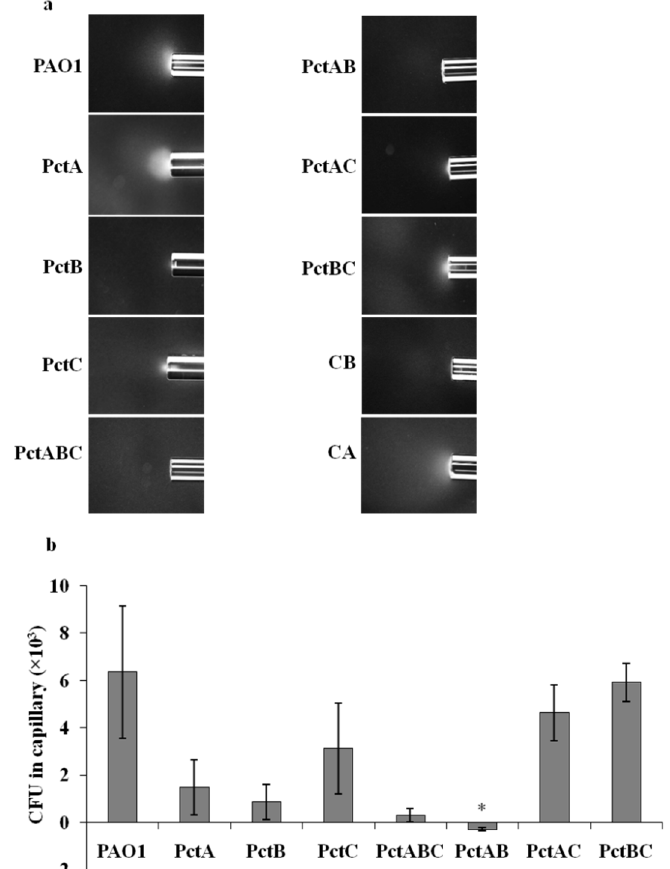
Figure 2. Capillary chemotaxis assays of wild-type PAO1, its mutant PAO1 ∆ pctA (PctA), PAO1 ∆ pctB (PctB), PAO1 ∆ pctC (PctC), PAO1 ∆ pctABC (PctABC), PAO1 ∆ pctAB (PctAB), PAO1 ∆ pctAC (PctAC) and PAO1 ∆ pctBC (PctBC) towards 1 mM L -ornithine. ( a ) Dark-field images of cells gathered at the mouth of capillaries containing attractants. All photographs were taken after 5 min. A normalization of the response visualized at 5 min with respect to the time 0 min for each treatment is represented with a jet Colormap (MATLAB R2013b version 8.2) in Supplementary Figure S3. Chemotaxis buffer (CB) and casamino acids (CA) were used as negative and positive control, respectively. ( b ) Quantitative comparison of L -ornithine chemotaxis response between the wild-type strain and its mutants indicated by Dunn’s test (* p < 0.05). The graph shows CFU in capillaries normalized by the negative control (CB). Results are averages of at least four independent experiments; error bars indicate standard errors.